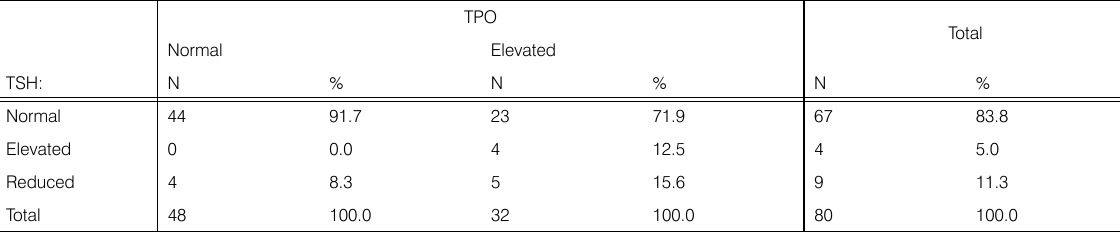
Table 1. Relation of TPO and TSH results